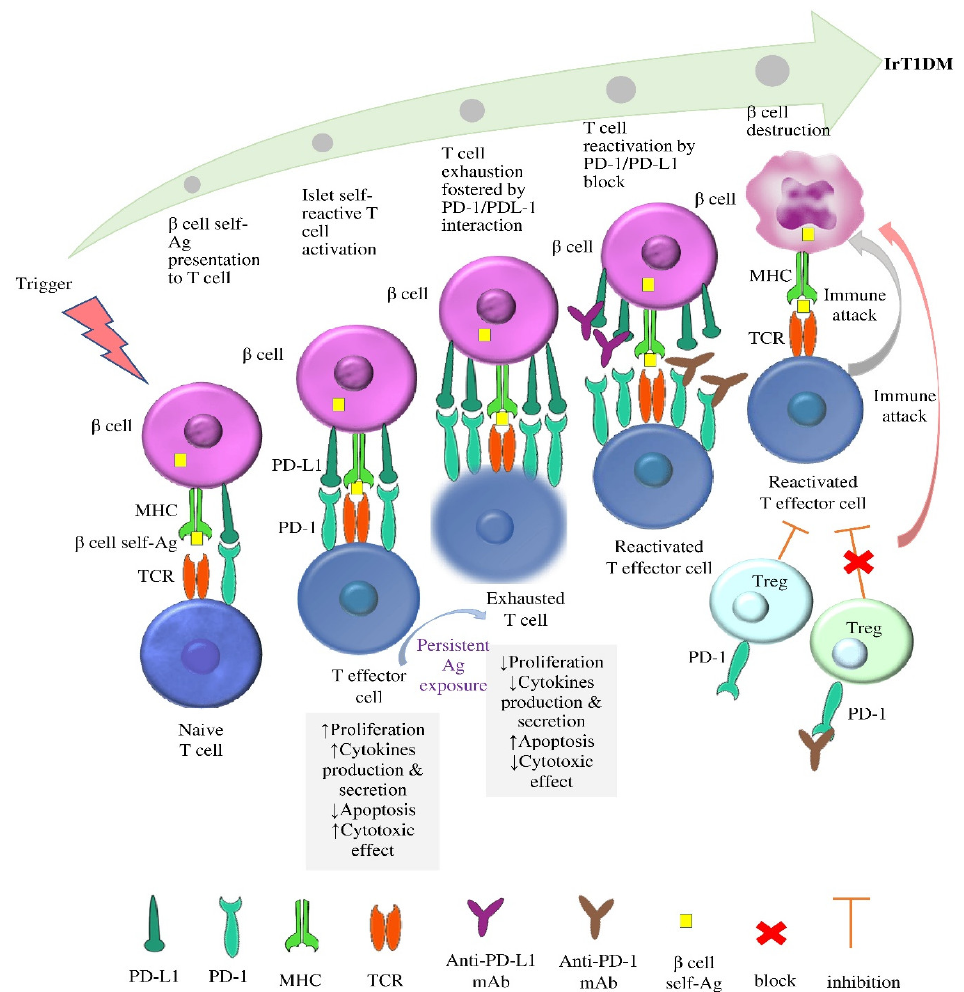
Figure 3. The postulated role of the disinhibition of PD-1/PDL-1 interaction in the pathophysiology of irT1DM.An unknown trigger, presumably environmental, can lead to β -cell stress, stimulating the induction of an immune attack against β cells through PD-L1 expression on β cells along with the recruitment of T cells expressing PD-1. PD-1 expression remains at a low basal level in naïve T cells, but it is induced early during the process of T-cell activation after the engagement of the TCR by the self-antigen/major histocompatibility complex ligand. Interaction of PD-L1 expressed on β cells with PD-1 expressed on activated T-effector cells is known to exert an inhibitory role, enhancing self-tolerance. As the chronic antigen exposure persists, PD-1 expression also persists and PD-1/PDL-1 interaction fosters the transition of T-effector cells to T-cell exhaustion, which is featured by the progressive loss of T-cell functions, averting islet autoimmunity. The disinhibition of PD-1/ PD-L1 interaction by anti-PD-1 or anti-PD-L1 mAbs reinvigorates T cells and allows them to attack β cells, resulting in β -cell destruction and eventually in T1DM. PD-1 is also expressed in T-regulatory cells, which are known to exert an immunosuppressive role inhibiting the function of reactivated T-effectors cells. Thus, inhibition of T-regulatory cells through anti-PD-1 mAbs can enhance the function of reactivated T-effector cells, allowing them to attack β cells, resulting in β -cell destruction and eventually in TIDM. Abbreviations: Ag, antigen; anti-PD-1 mAbs, monoclonal antibodies against programmed cell death (PD) 1 (PD-1), anti-PD-L1 mAbs, antibodies against the ligand of PD-1 (anti-PD-L1), MHC, major histocompatibility complex; PD-1, programmed cell death PD-L1, ligand of PD-1; TCR, T-cell receptor; Treg, T-regulatory